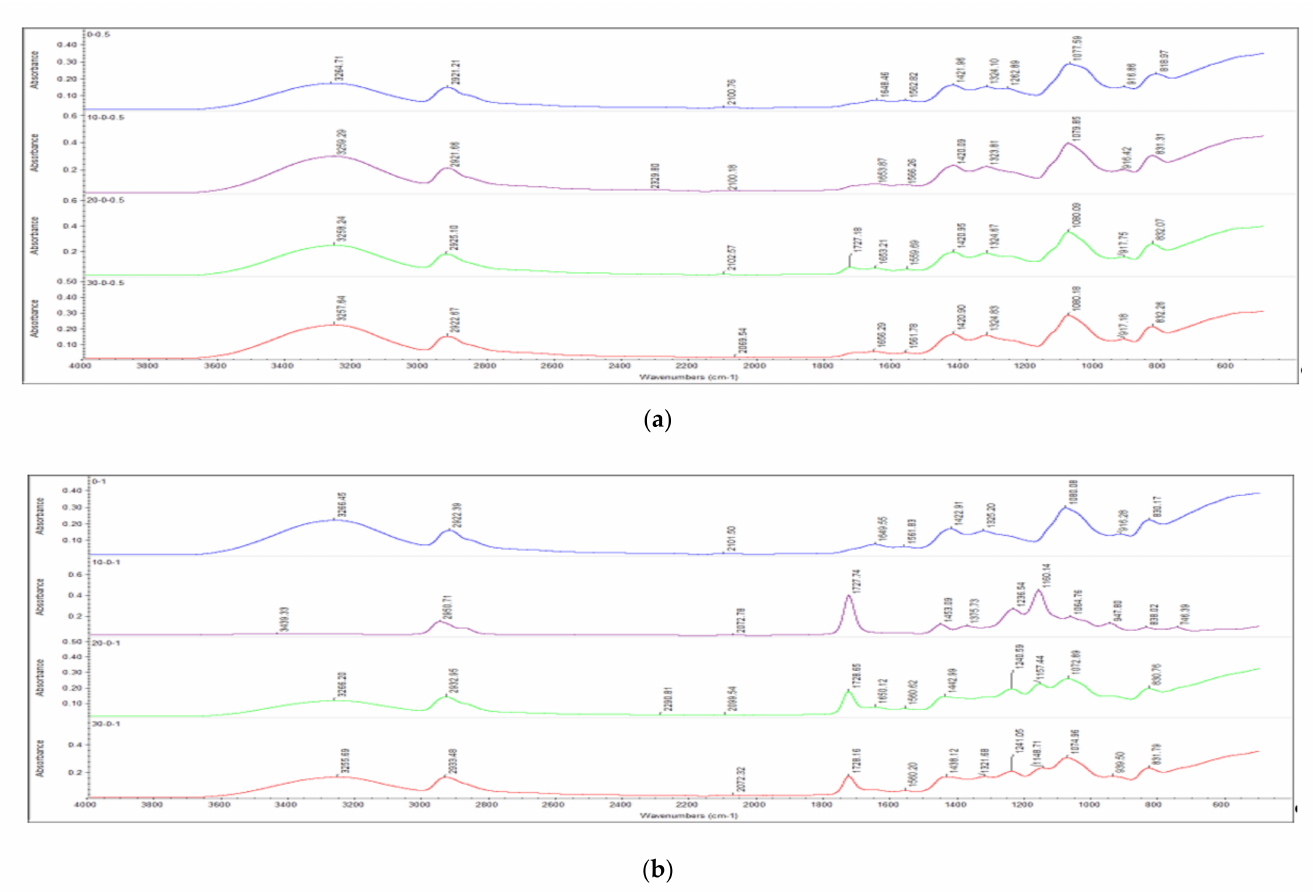
Figure 3. Effects of increasing electron beam irradiation dosages on FTIR spectrum of ( a ) 0.5 phr CNTs and ( b ) 1.0 phr CNTs added polyvinyl alcohol (PVOH)